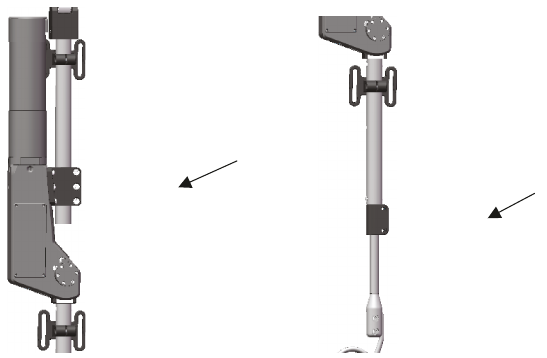
Figure 3: Thigh and calf adjustable